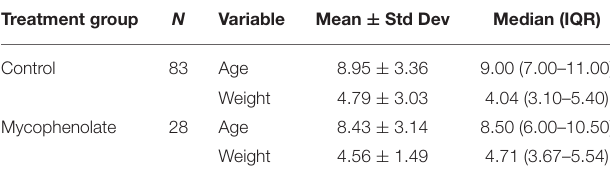
TABLE 2 | Age (years) and weight (kilograms) distribution of treatment groups. Treatment group